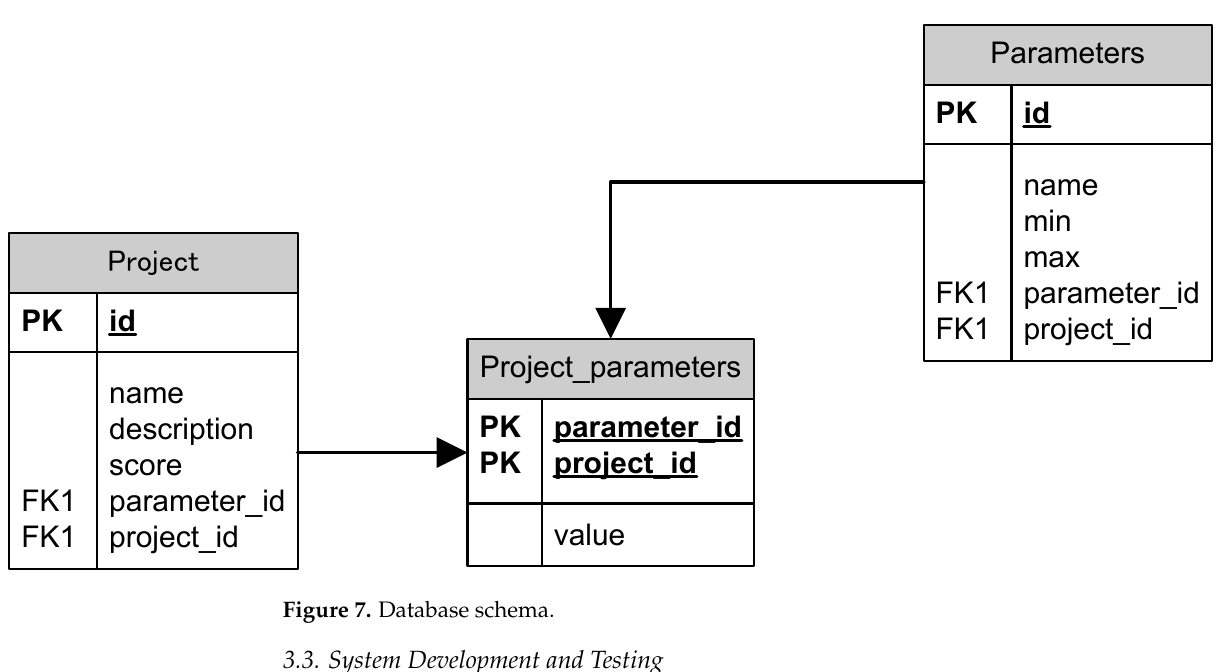
Figure 7. Database schema.